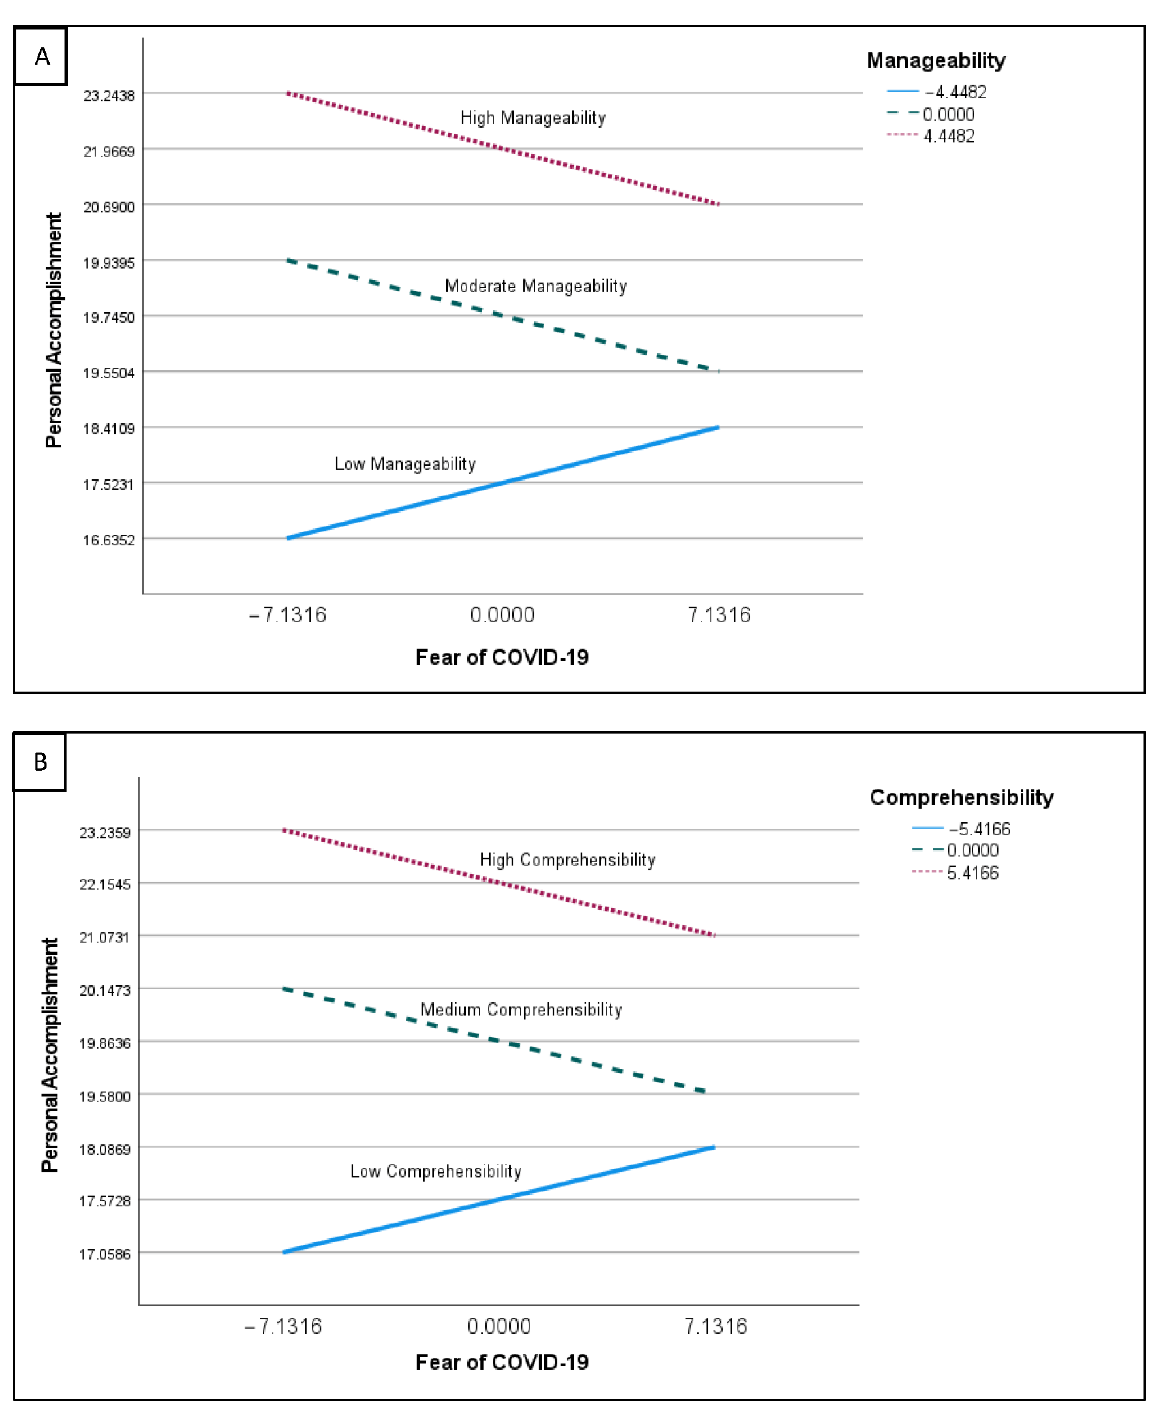
Figure 2. The relationship between fear of COVID-19 and personal accomplishment for three different groups in terms of manageability and comprehensibility. Note. Manageability: − 4.45 = low (solid line), 0.00 = moderate (dash line), 4.45 = high (dotted line). Comprehensibility: − 5.42 = low (solid line), 0.00 = moderate (dash line), 5.42 = high (dotted line).